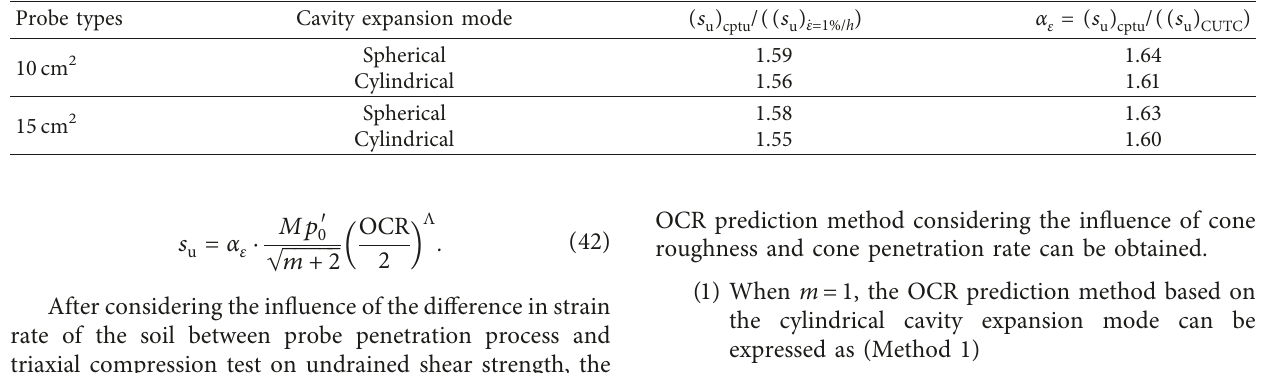
Table 1: α ε with different types of CPTU